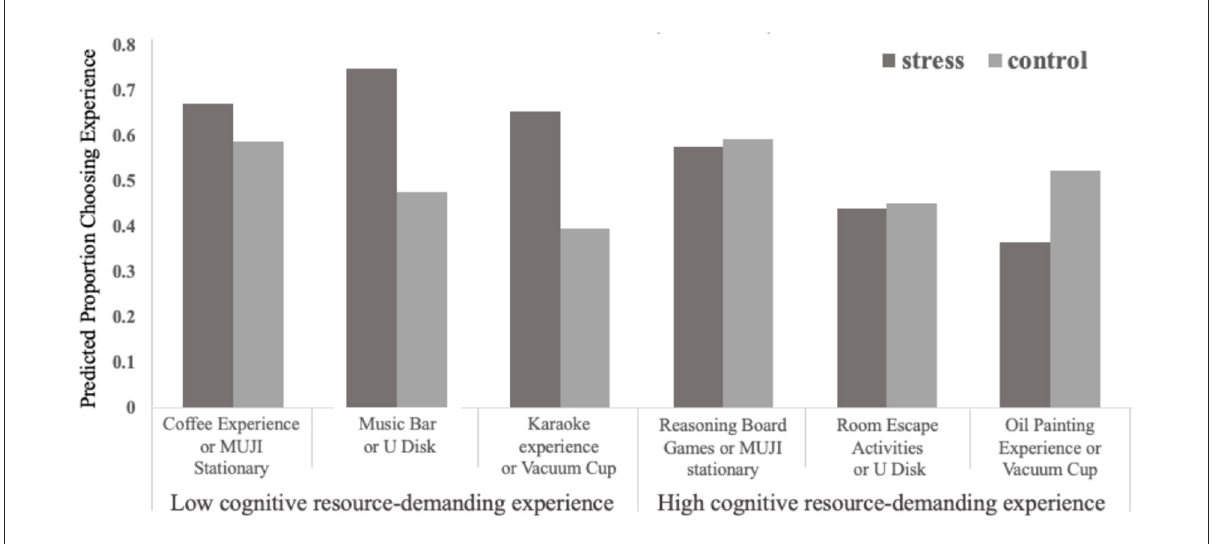
FIGURE3 Proportion of participants choosing the experiential option, across five replicates, by condition (study